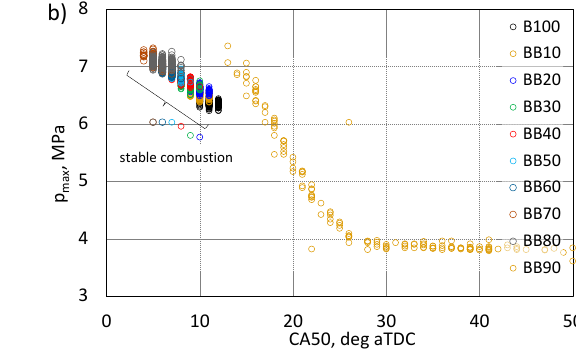
For an engine powered by DB up to a 50% share of n ‐ butanol, the angle CA50 is close